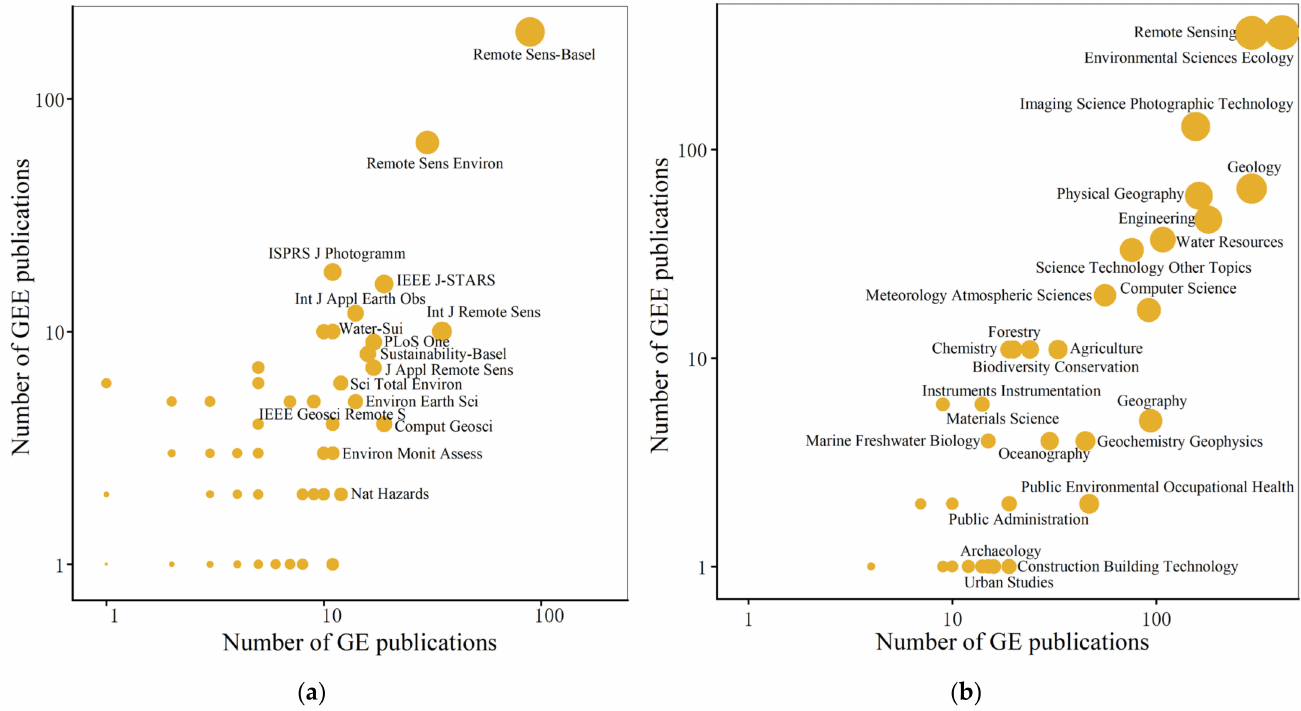
Figure 6. Numbers of published GE and GEE papers shown by ( a ) journal and ( b ) research